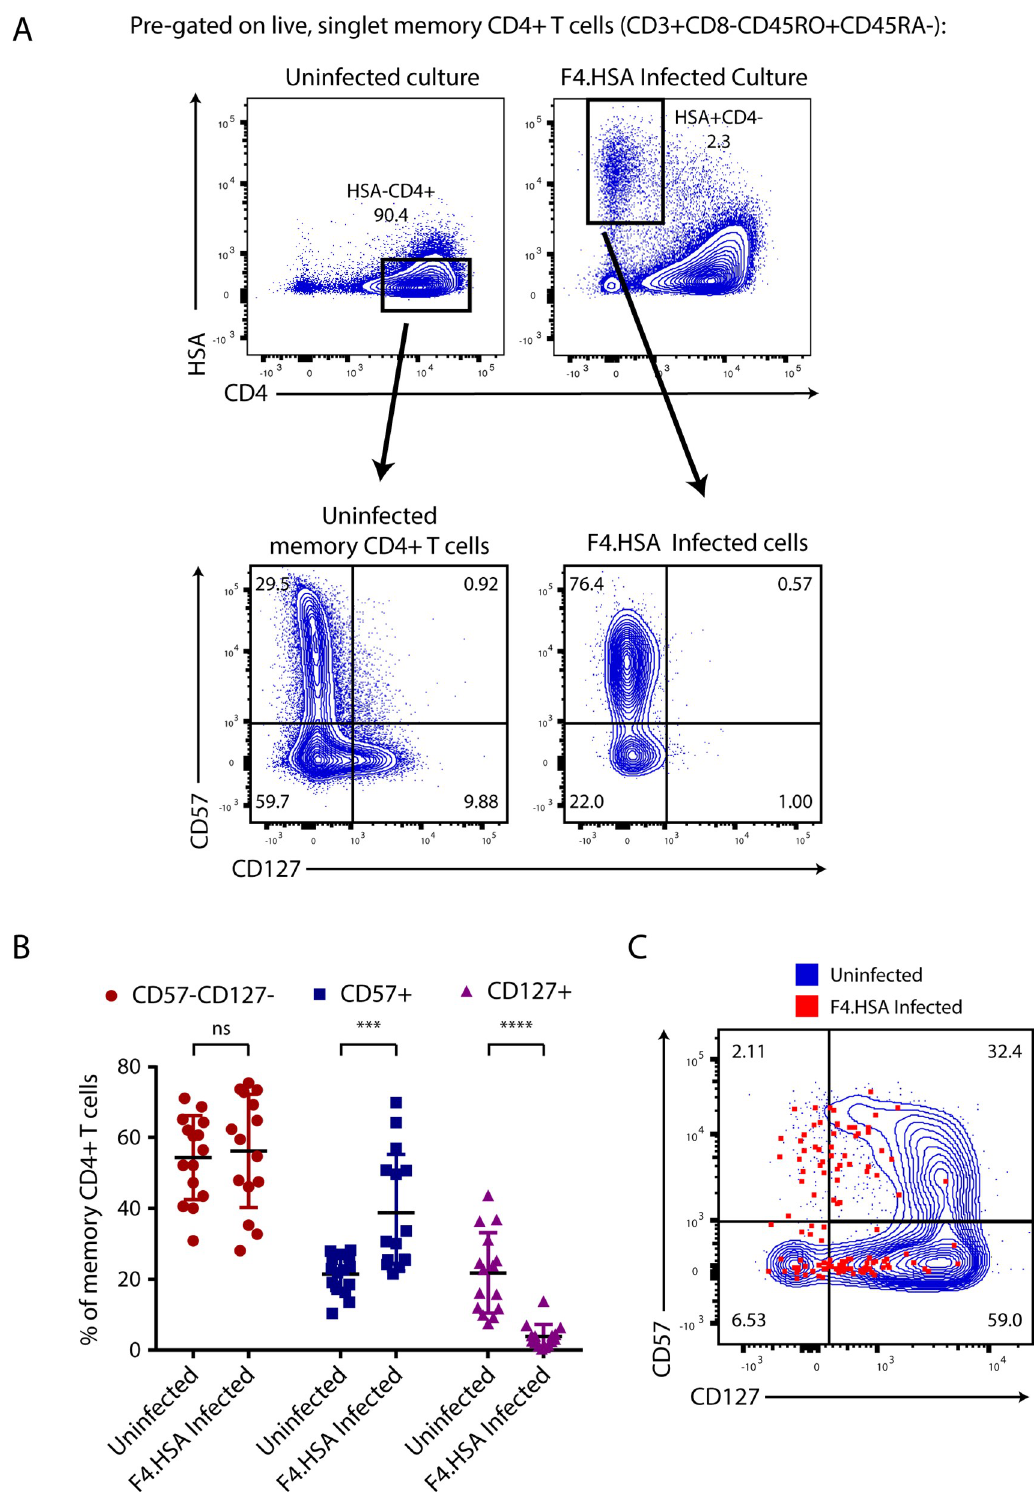
Fig 1. CD127+ memory CD4+ T cells from tonsils are poorly susceptible to productive infection by HIV-1. A) CD127+ Tm cells are preferentially absent amongst infected tonsillar cells. HLACs were mock-treated or exposed for 3 days to the CCR5-tropic reporter virus F4.HSA, after which the populations of uninfected memory CD4+ T cells ( top left ) and infected memory CD4+ T cells that have downregulated cell-surface CD4 ( top right ) were assessed for expression levels of CD57 and